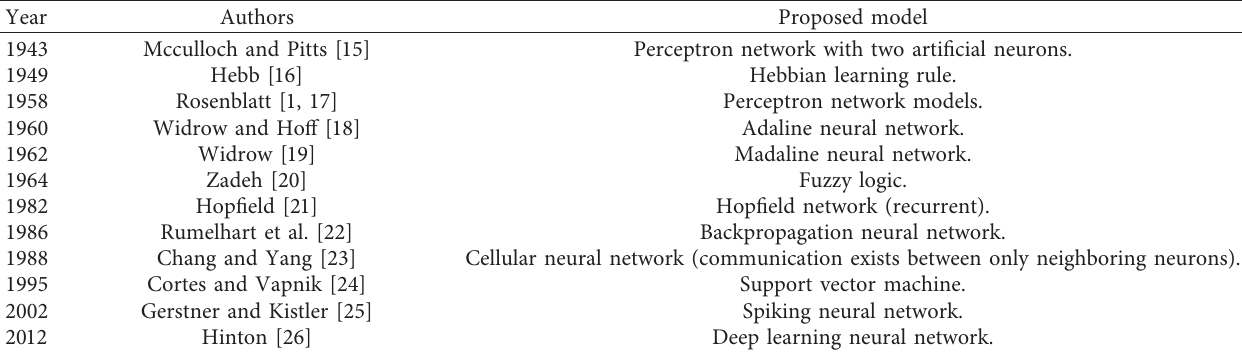
Table 1: Development of ANN in the